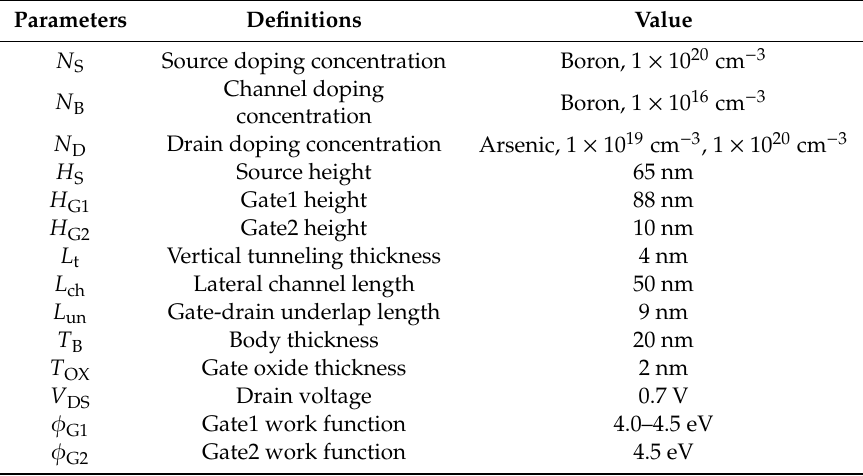
Figure 1. Schematic designs of ( a ) (conventional) single gate L-shaped tunnel field-effect transistor (TFET), ( b ) single gate L-shaped TFET with underlap, ( c ) stacked gate L-shaped TFET and ( d ) stacked gate L-shaped TFET with underlap. In order to compare the suppression of the ambipolar current for each method, the simulations were conducted according to the schematics above. Table 1. Simulation parameters used for this work.